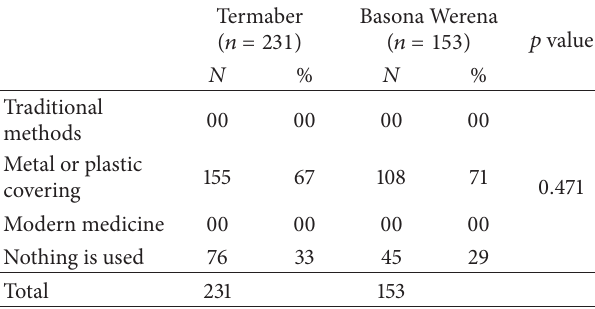
Table 6: Reported mechanism of disease